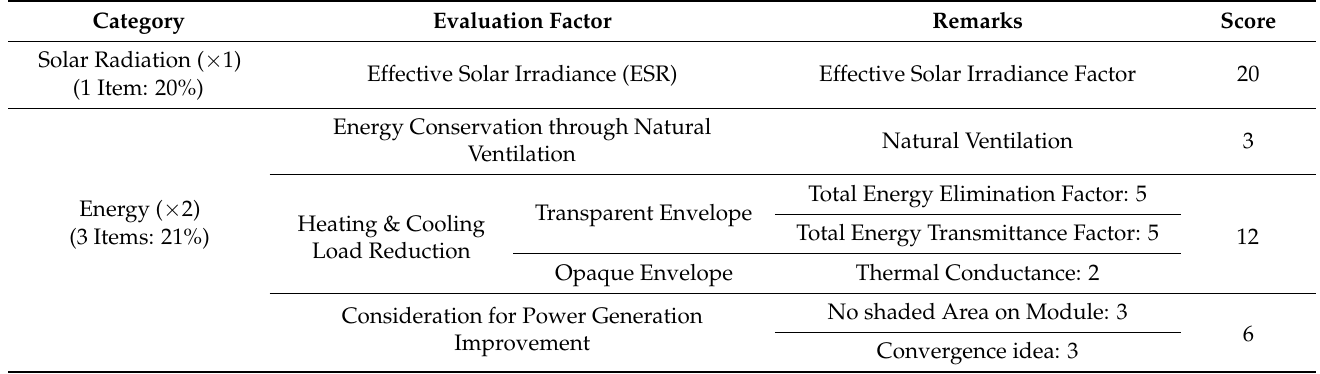
Table 1. Ecological design criteria for Solar Architecture Integrated Bi-facial Photovoltaic. Category Evaluation